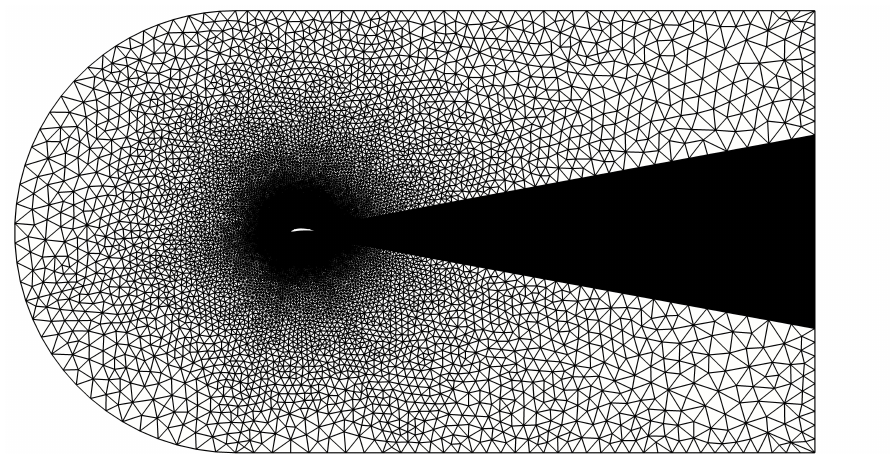
Figure 3. Overall view of the computational domain.